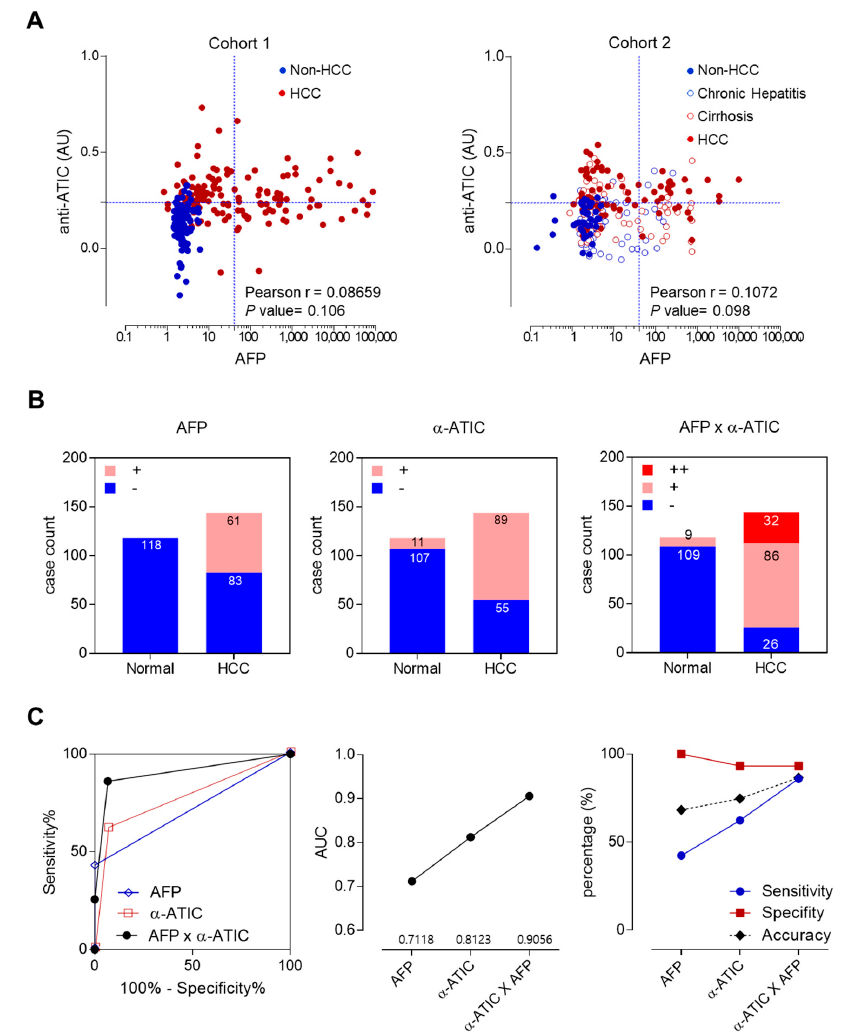
Figure 5. Combinational analysis of HCC biomarkers enhanced the diagnostic accuracy. ( A ) Pearson analysis of correlations between anti-ATIC autoantibody biomarker and AFP was performed (see also Supplementary Figure S6). ( B ) Combinational analysis of HCC biomarkers, anti-ATIC autoantibody